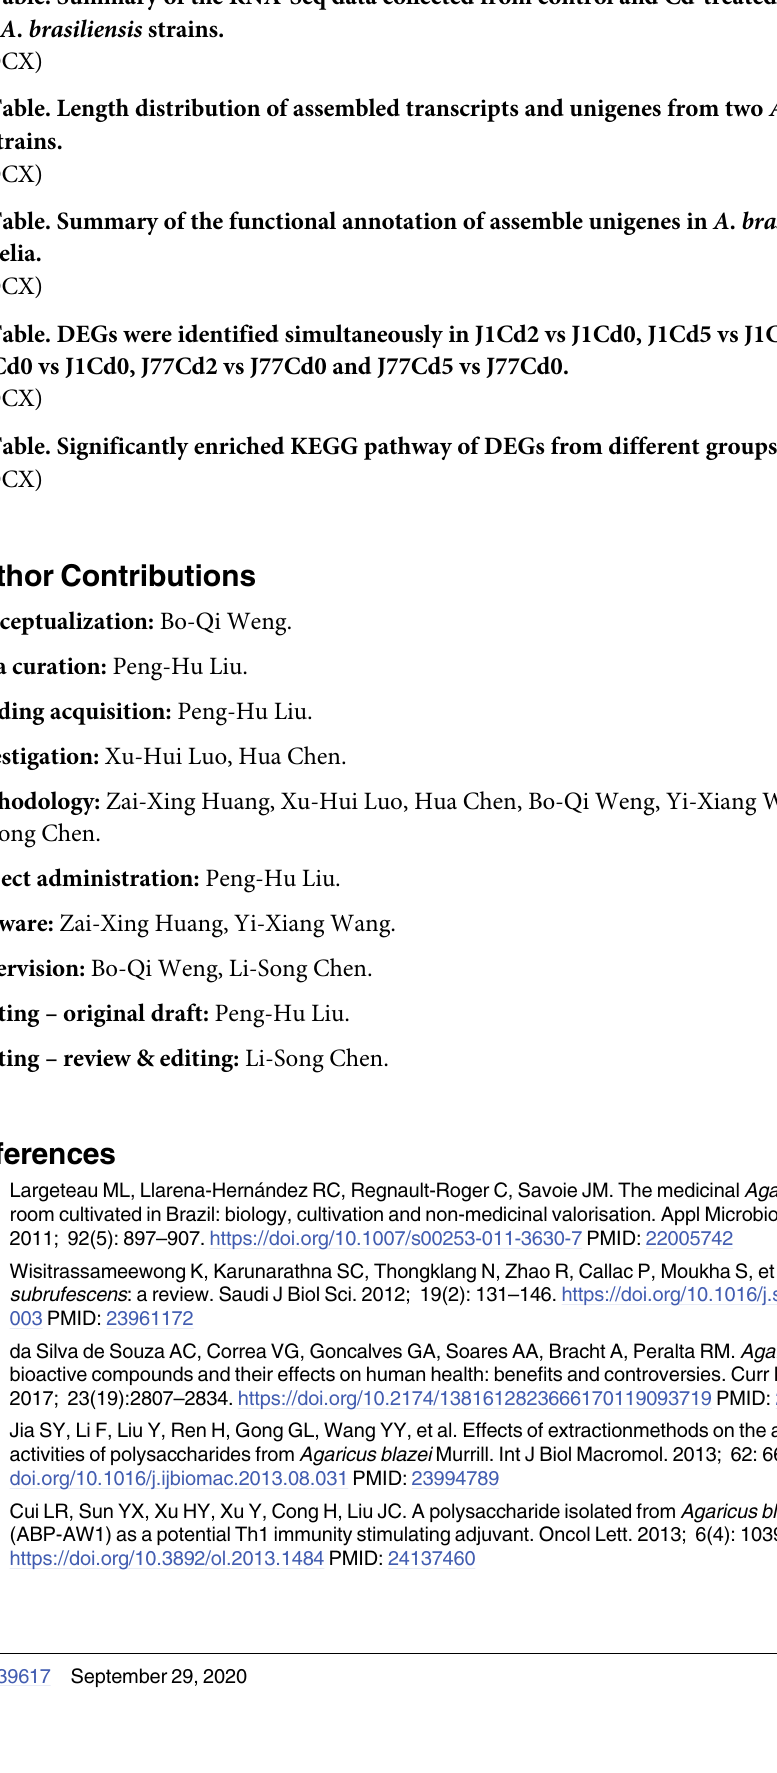
S2 Table. Summary of the RNA-Seq data collected from control and Cd-treated mycelia of